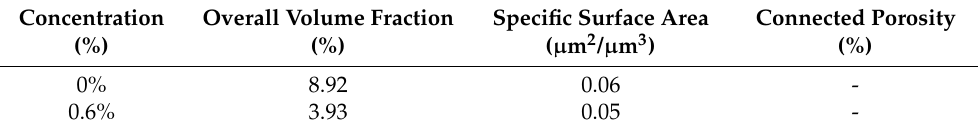
Table 4. Comparison of the 3D structural parameters.